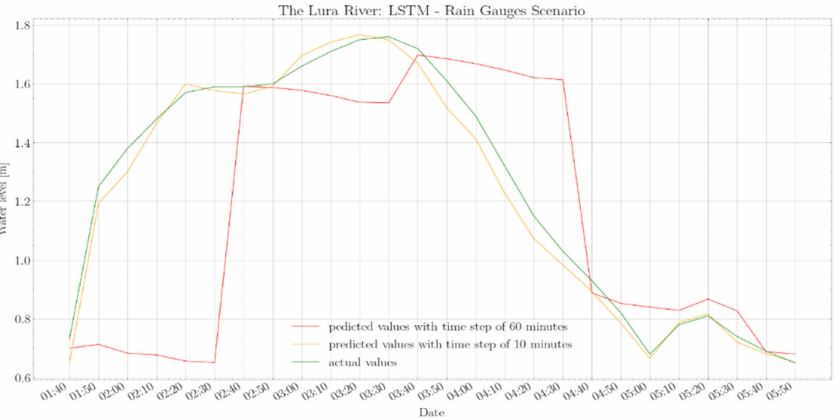
Figure 11. Performance of multivariable LSTM. Rain gauges scenario: test flood event of 21 July 2018, Lura River. Actual ( green ) and forecasted water levels with 60- ( red ) and 10-min ( orange ) input